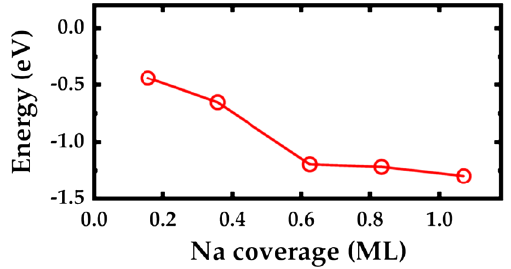
FIG. 3. Dirac-point shift with reference to the Fermi level as a function of the Na coverage. All data are obtained for the majority-spin